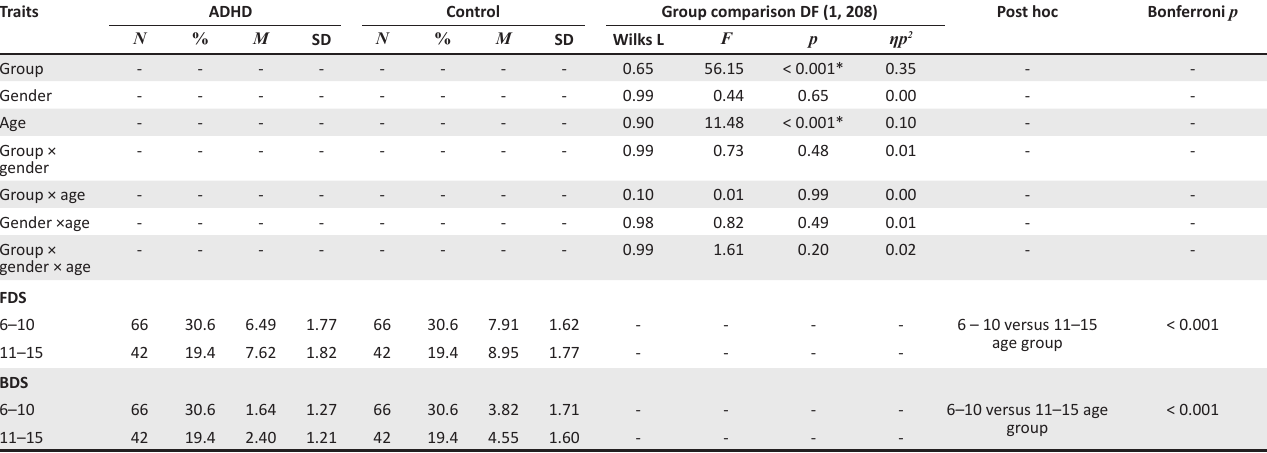
TABLE 1: Descriptive statistics and MANOVA results for